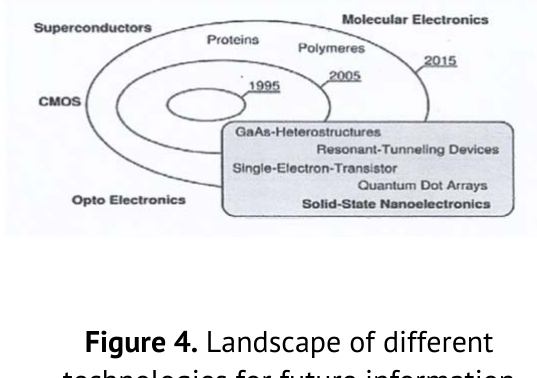
Figure 4. Landscape of different technologies for future information processing [23].